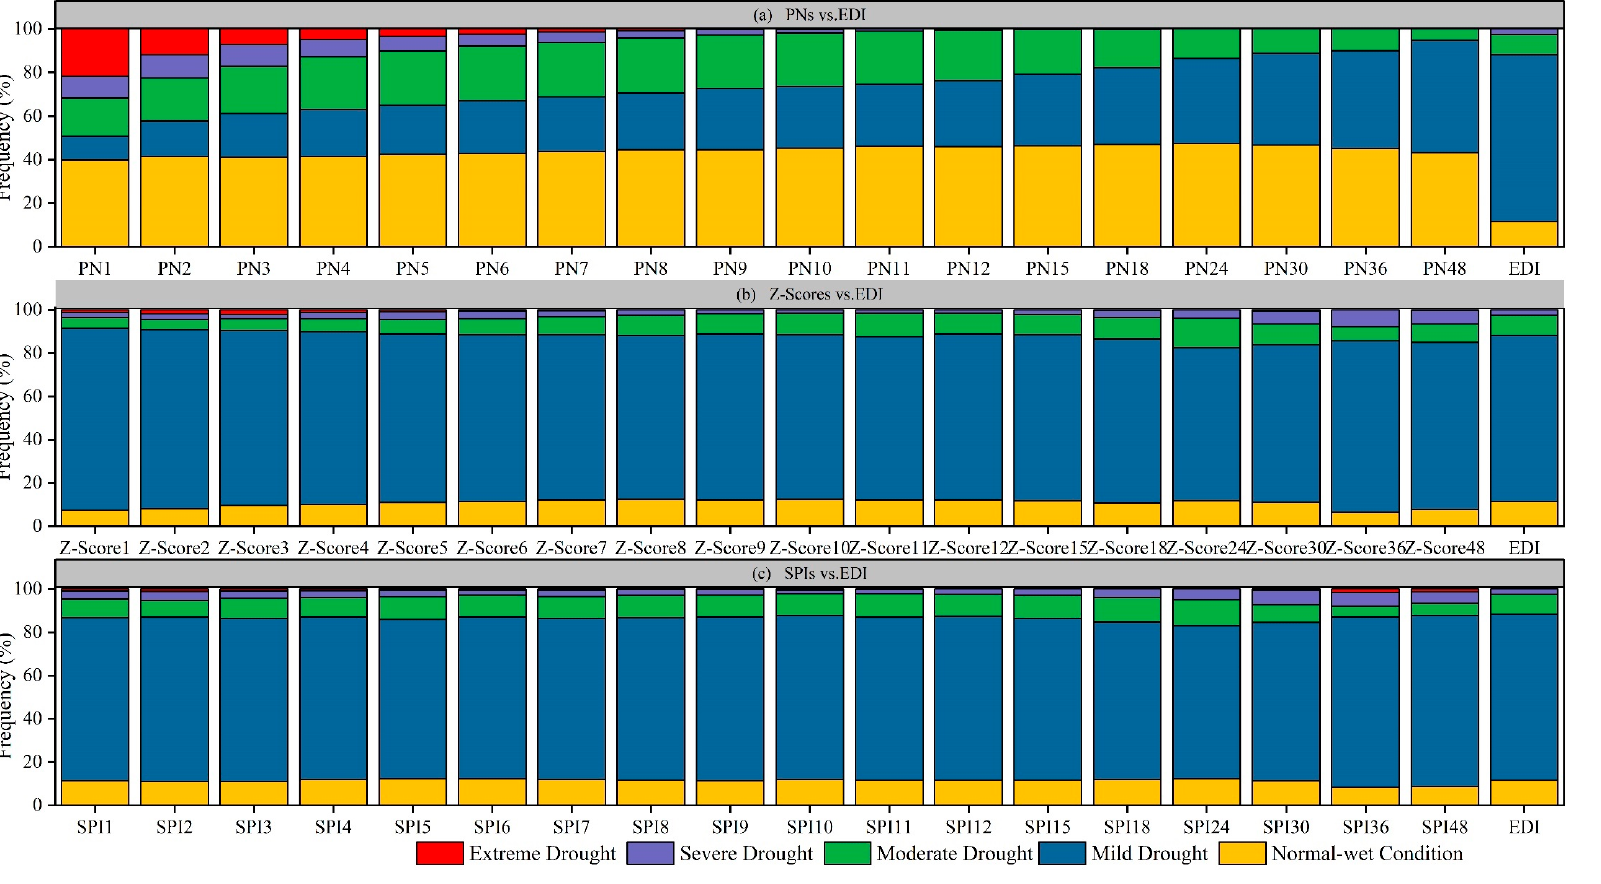
Figure 4. Drought frequency identified by PNs vs. EDI ( a ), Z-Scores vs. EDI ( b ) and SPIs vs. EDI ( c ) in the WRB during 1960–2010.